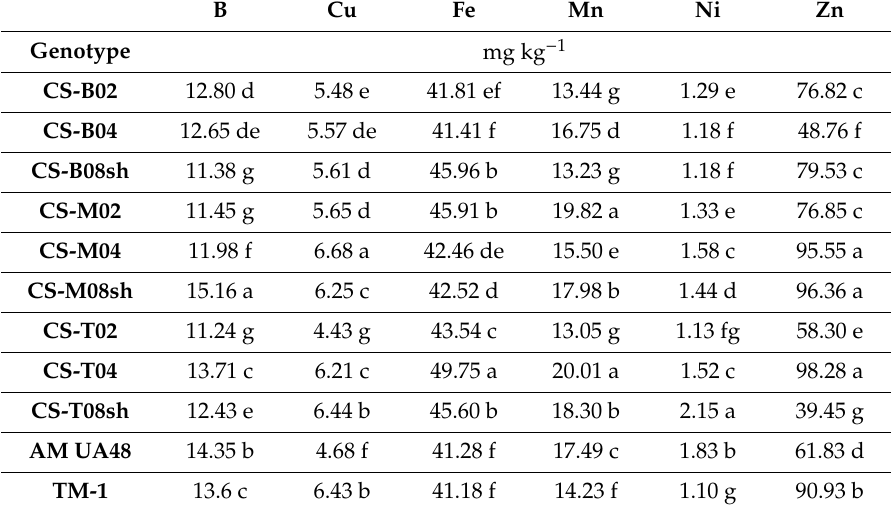
Table 3. Experiment 2: E ff ects † of CS on cottonseed mineral concentrations (mg kg − 1 ). The experiment was conducted in 2014, Mississippi State, MS, USA.